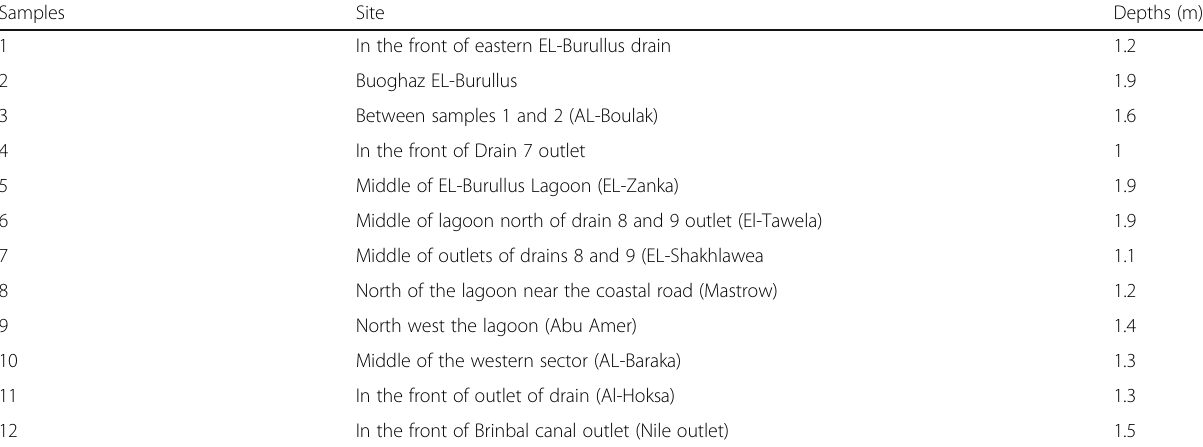
Table 1 Description of the collected sediments from lagoon Burullus Samples